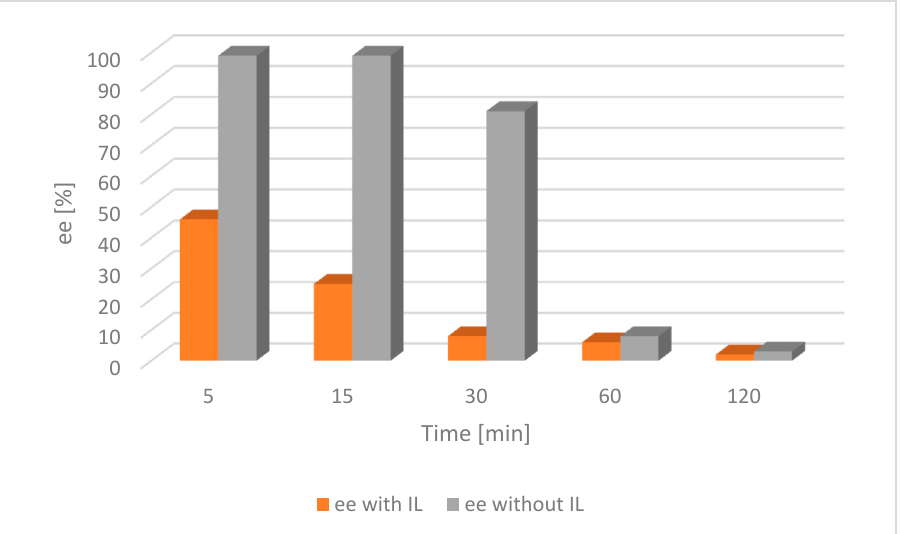
Figure 7. Comparison of the catalytic activity of [Ru(2)] with and without an IL for alcohol 2. Ruthenium [Ru(2)] 0.004 mmol, t BuOK 0.02 mmol, alcohol 0.25 mmol, [BMIM][NTf 2 ] 0.07 mmol, toluene 2 mL, a nitrogen atmosphere, RT; ee—enantiomeric excess of chiral alcohol in the mixture; the lower the ee, the nearer completion the desired racemization reaction.